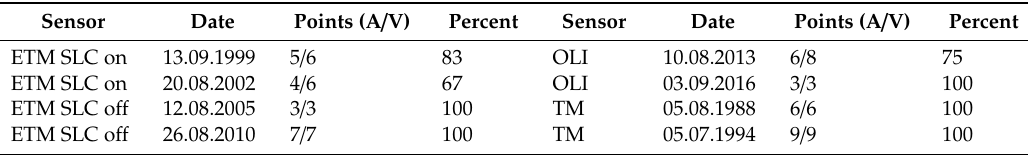
Table 4. Performance of the snow cover mapping for eight Landsat scenes and four glaciers (5, 8, 17, 20). The columns ‘Points (A / V)’ give the number of points (see Figure 3) classified by ASMAG (A) and visually (V) as snow. In total, 43 out of 48 points (90.6%) are classified correctly.